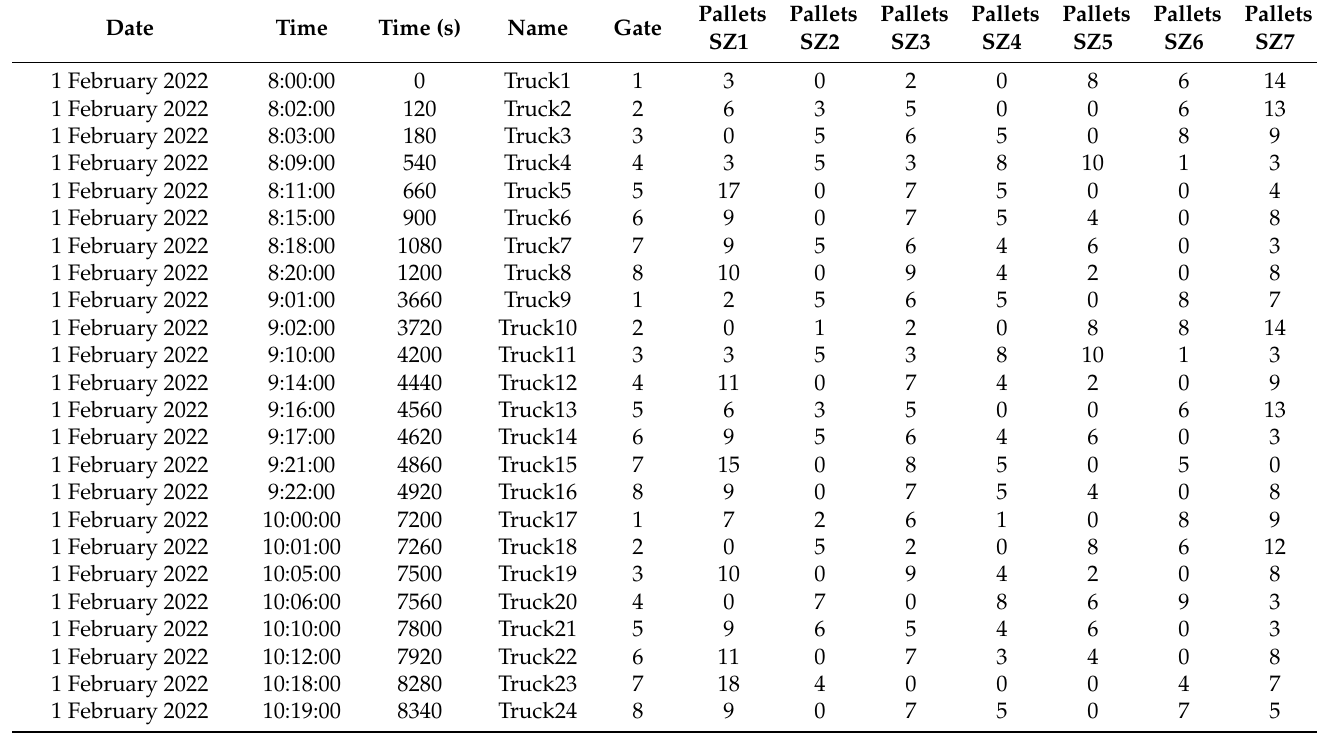
Table 1. The trucks arrivals input data recorded on 1 February